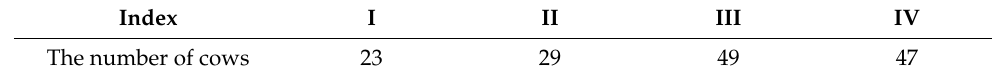
Table 1. Primary classification results.